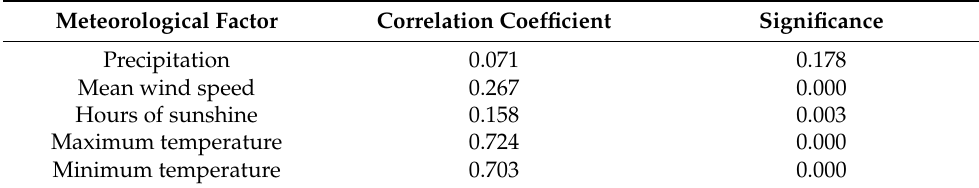
Table 3. Correlations between O 3 concentration and meteorological factors.